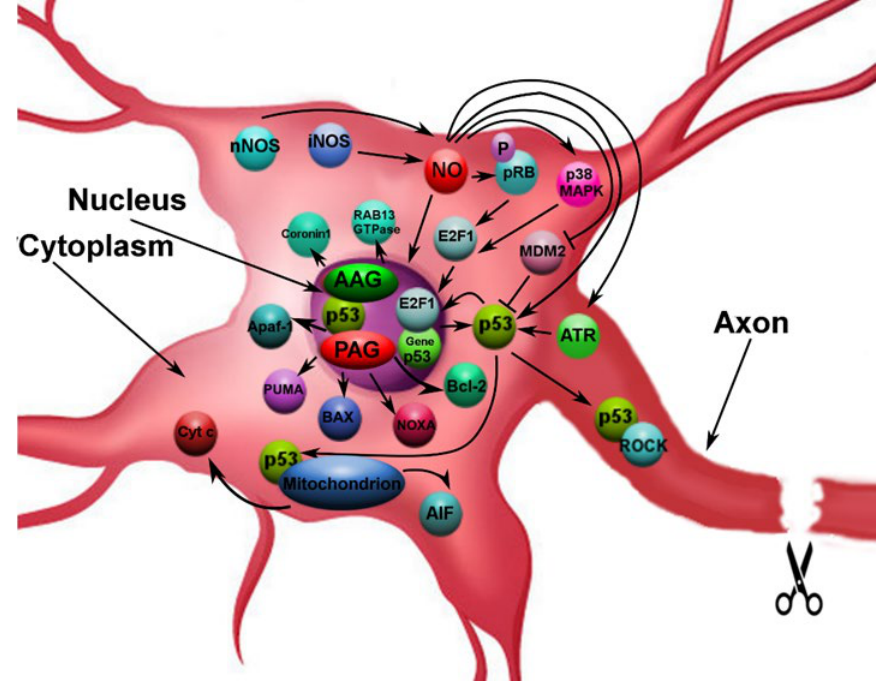
Figure 7. Scheme of NO-dependent realization of pro- and anti-apoptotic p53-signaling pathways in axotomized neurons. The NO, which is generated by iNOS and nNOS in result of axonal stress, may regulate p53 expression and localization by a variety of direct and indirect ways. Note: PAG—pro-apoptotic genes; AAG—anti-apoptotic genes.